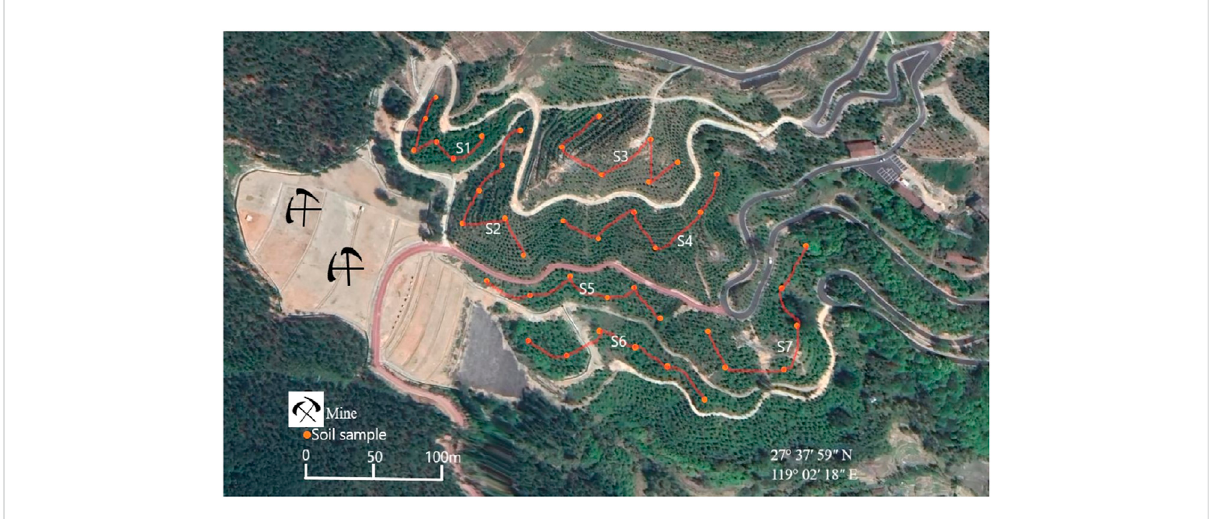
FIGURE 1 Abandoned Pb/Zn mining area and sampling site in Qingyuan County (the satellite imagery was obtained from the Bigemap version 29.6.3.0 software and can be downloaded for free from